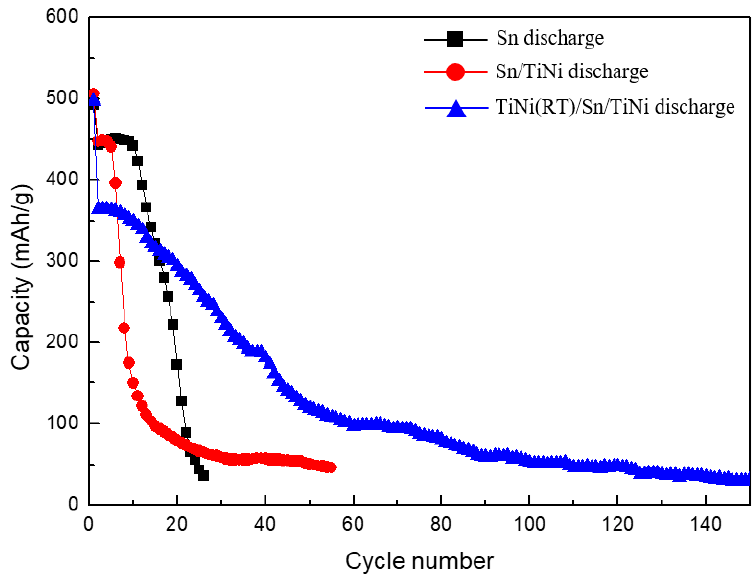
Figure 10. Cycle performance of Sn, Sn/TiNi, and TiNi(RT)/Sn/TiNi electrodes at 0.5 C. To find the cause of the cycle-performance improvement in the TiNi(RT)/Sn/TiNi electrode, electrochemical impedance spectroscopy was performed at a voltage amplitude